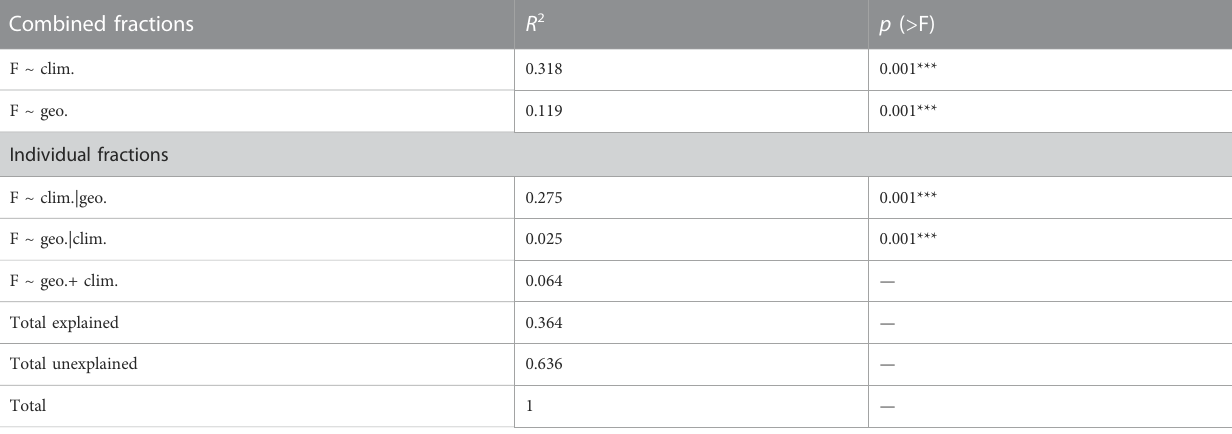
TABLE 2 RDAs to partition genomic variation among T. hemsleyanum populations into climate, geography and their combined fractions. Combined fractions R 2 p ( > F) F ~ clim.